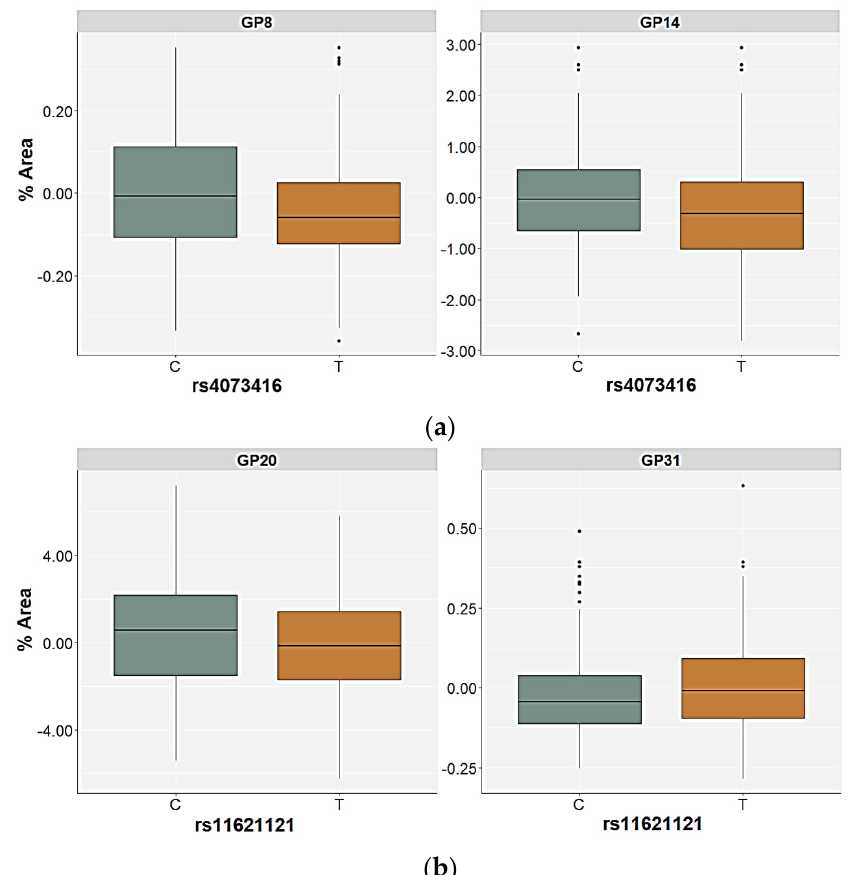
Figure 4. Relative distribution of the plasma N-glycan levels in the carriers of different alleles for ( a ) the rs4073416 polymorphism in the control group and ( b ) the rs11621121 polymorphism in the PTSD group. The central box represents the interquartile range of the age-adjusted percentage of the total glycan peak area, the middle line represents the median, the vertical line extends from the minimum to the maximum value, and separate dots represent the outliers.